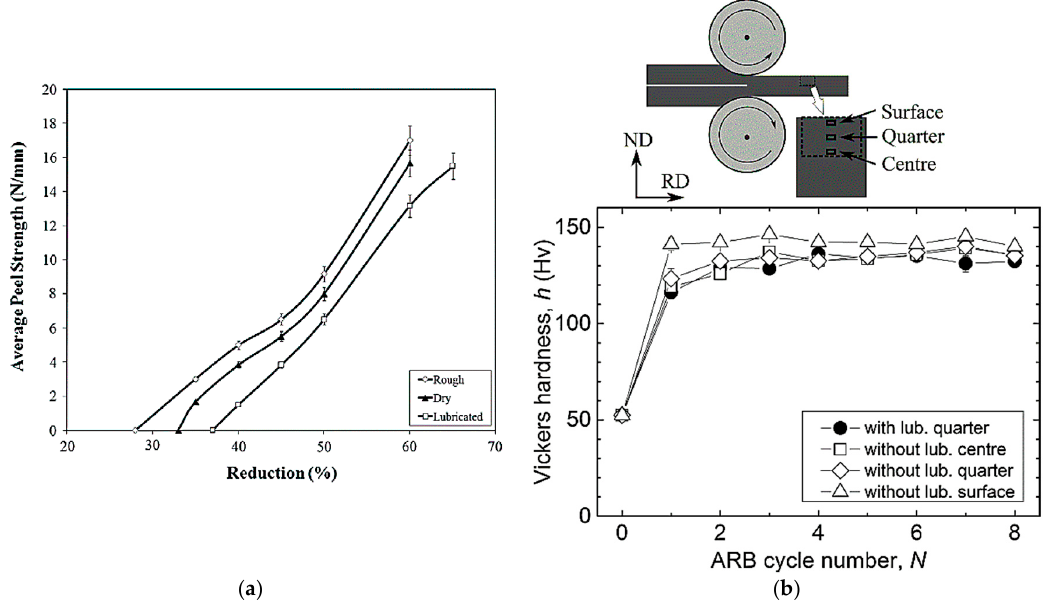
Figure 6. ( a ) Average peel strength versus the reduction in three frictional conditions, i.e., rough, dry and lubricated surface conditions [32], ( b ) Hardness of ARBed 4N-Cu with and without lubrication [50].